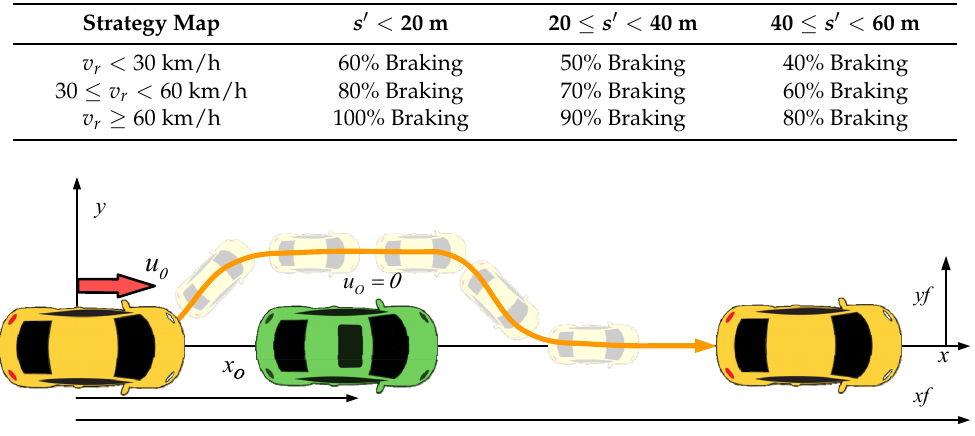
Table 1 . Braking conditions for one ‐ dimensional CAS (collision avoidance system).